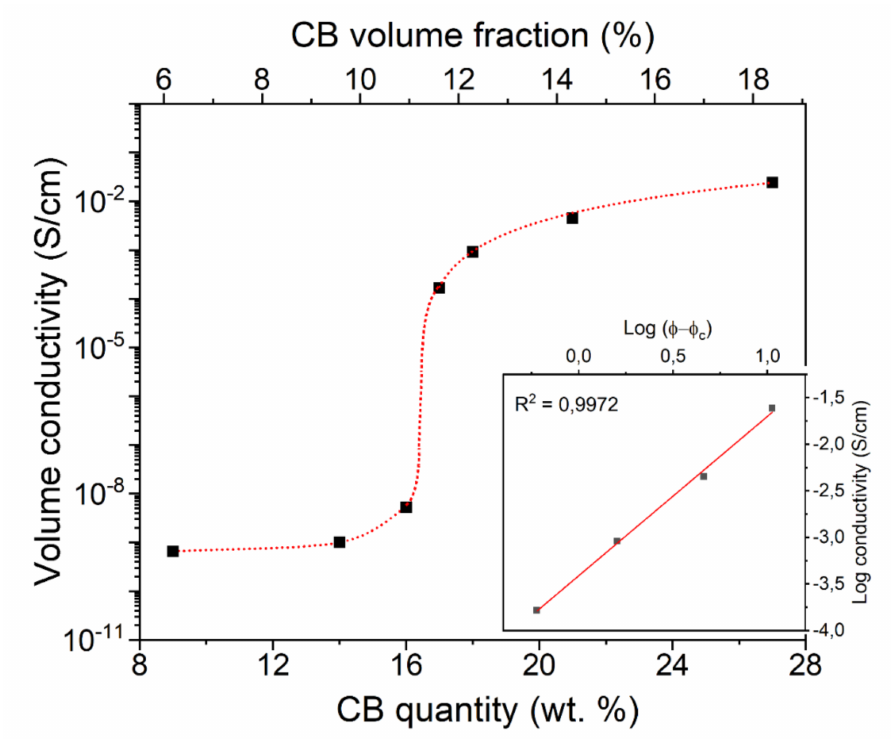
Figure 4. Room temperature electrical conductivity as a function of the CB loading in CB-filled melt-compounded PA composites. The log–log plot of conductivity at 25 ◦ C is shown in the